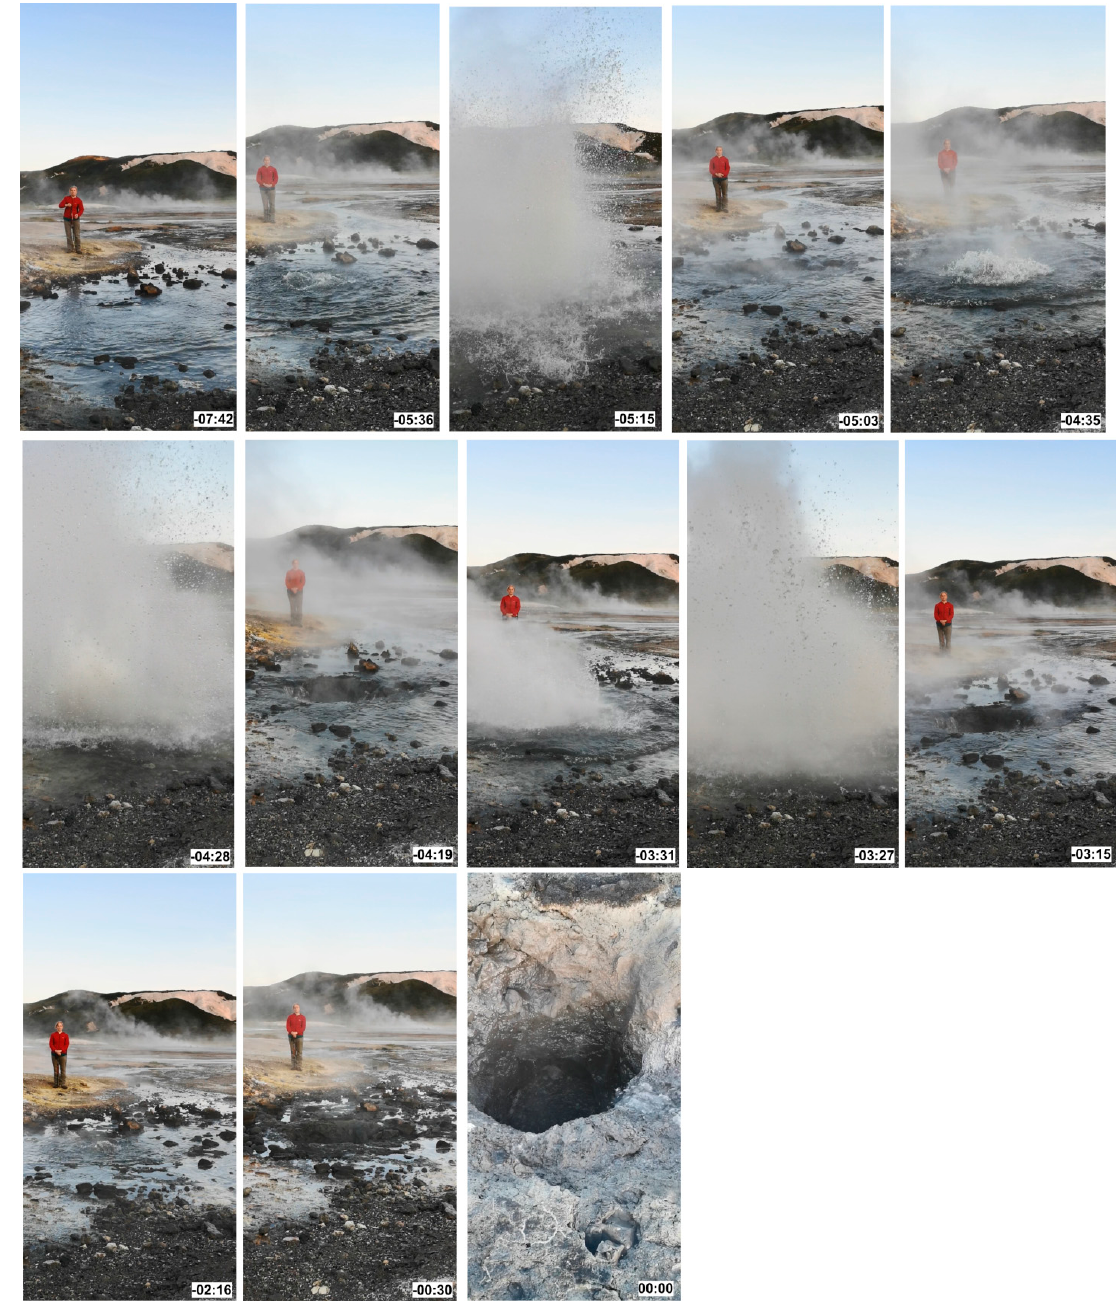
Figure A7. Shaman geyser eruption events on 24 August 2019 20:01. Times (negative): − 07:42—